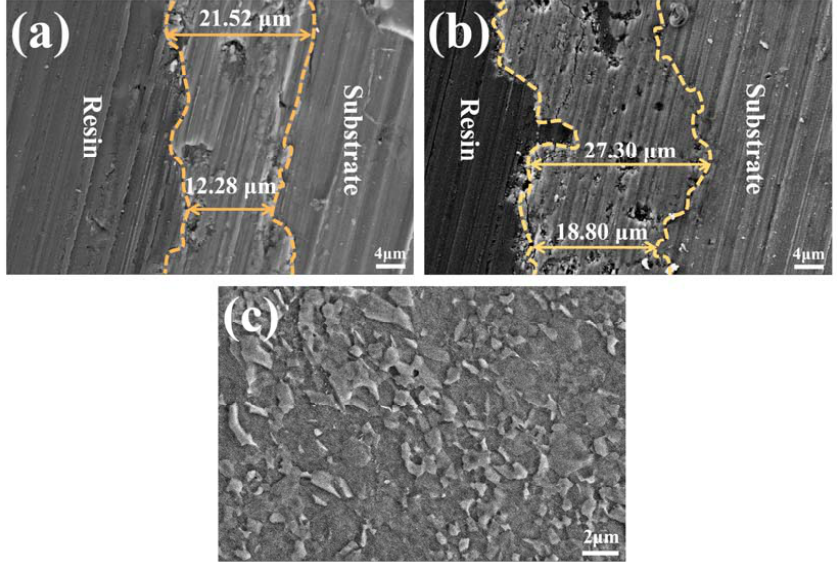
Figure 3. Cross ‐ section SEM images of MAO coating: ( a ) CG ‐ MAO and ( b ) FG ‐ MAO; ( c ) SEM image underneath the coating in FG ‐ MAO sample.